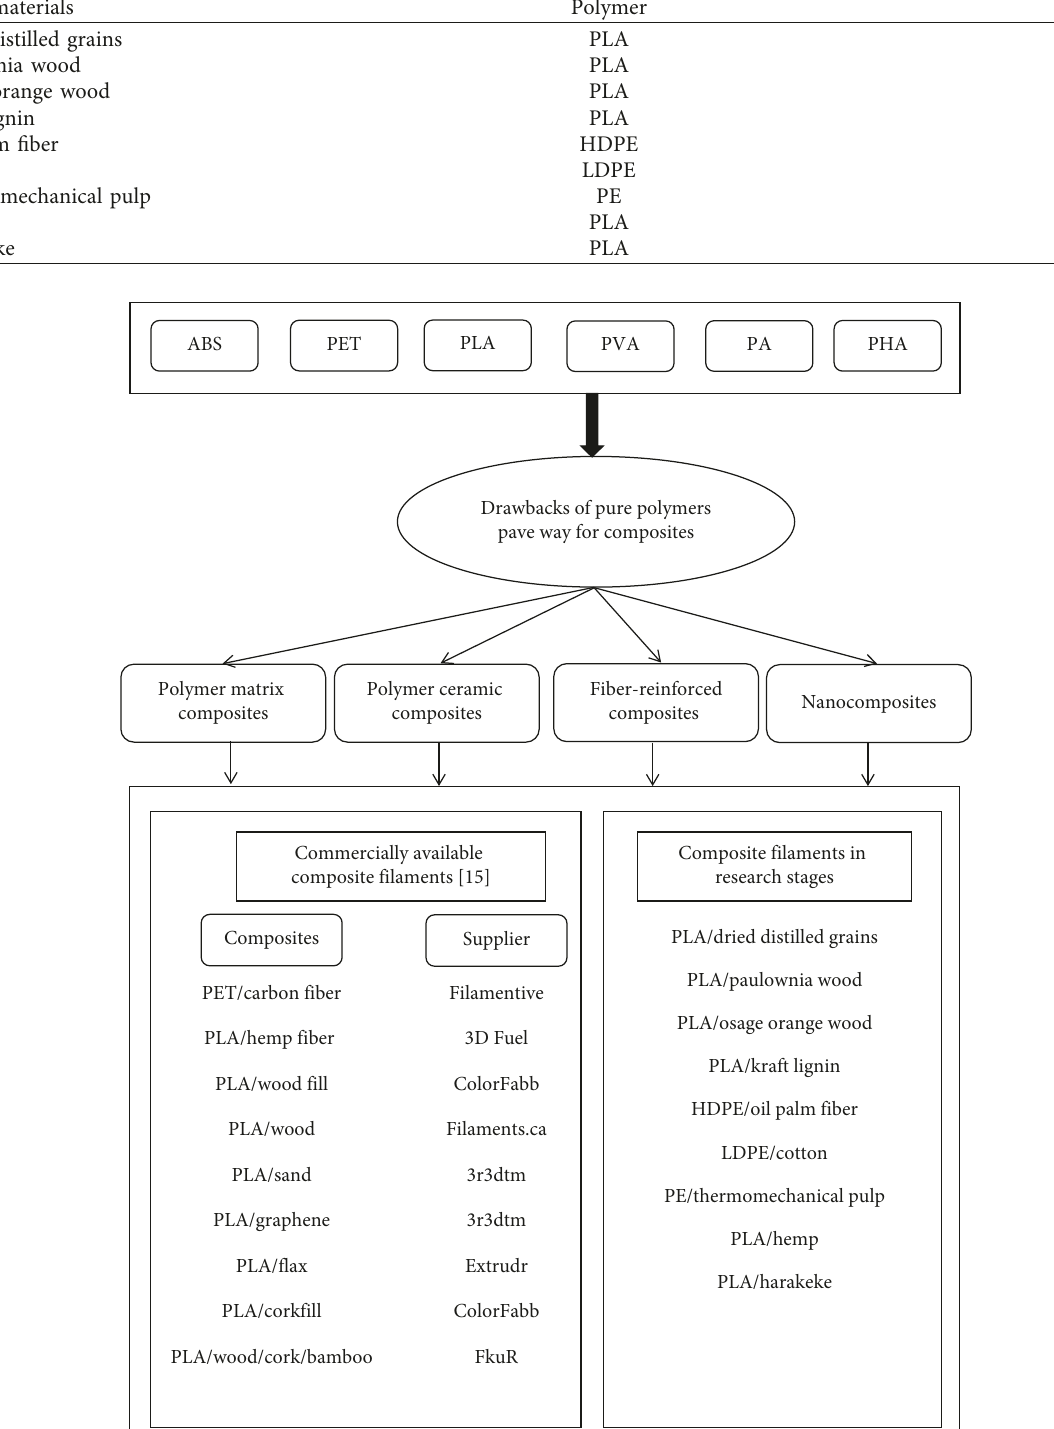
Table 15: Available bio-based polymer filaments.